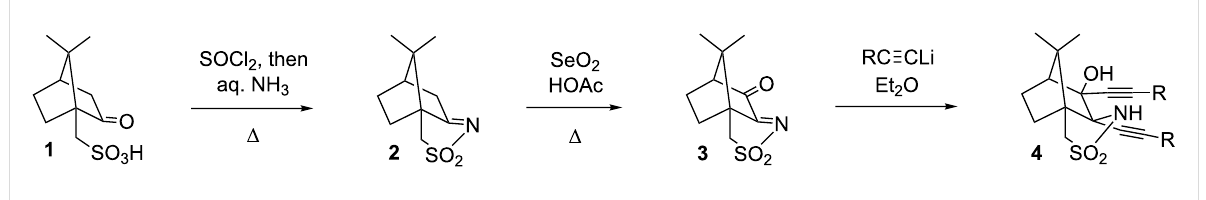
Scheme 1: Synthesis of 3-oxo-camphorsulfonylimine ( 3 ) [13,15] and its bis-alkynyl derivatives 4 from camphor-10-sulfonic acid ( 1